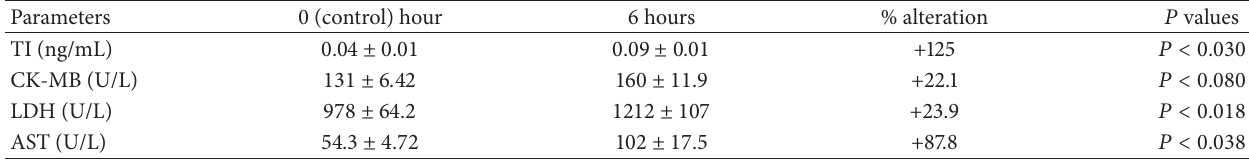
Table 1: The effect of diclofenac (2.5 mg/kg, IM) treatment on cardiac damage markers in rams (mean ±